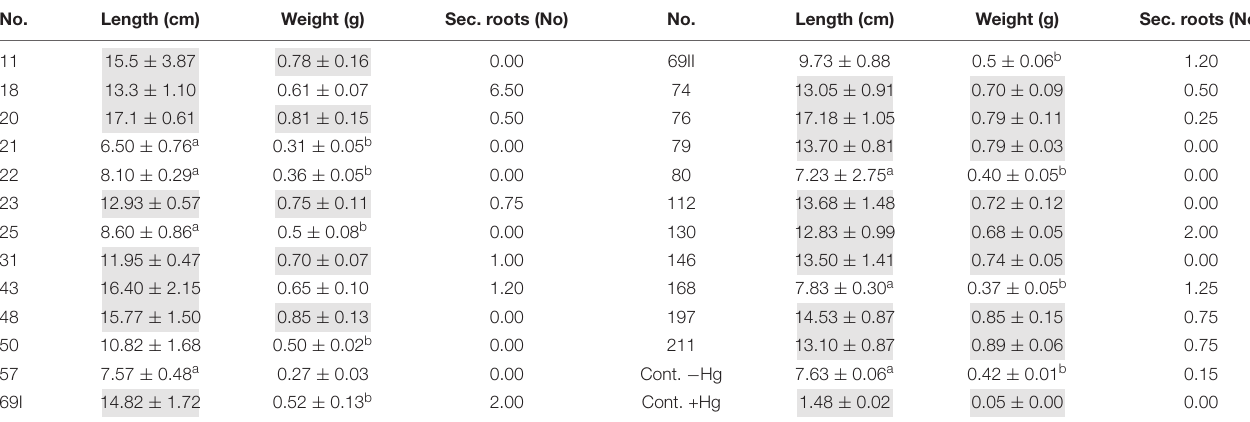
FIGURE 1 | The mean ( n = 5 of experimental units with 9 seeds) germination number of seeds (No), root length (cm), and root weight (g) for each concentration of HgCl 2 tested ( µ g ml − 1 ), after 120 h of development. TABLE 2 | The mean values of replicates ( n = 5) ± SD for root length (cm), root weight (g) of the different treatments, and controls (absence of Hg and presence of